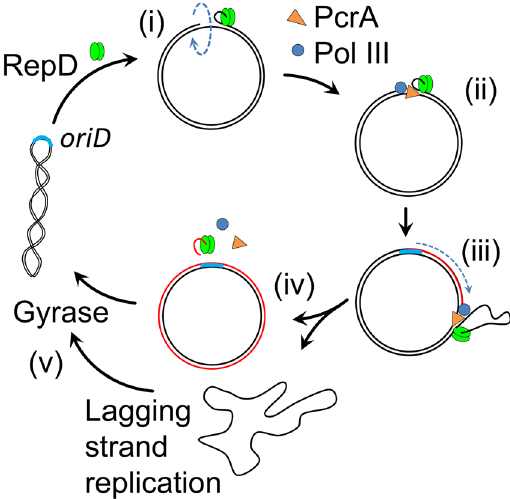
Figure 1. The rolling circle plasmid replication (i) The initiator protein (RepD, green) nicks DNA at the site of double-stranded origin oriD making a covalent complex with DNA. (ii & iii) PcrA helicase (orange) binds the exposed section of single-stranded DNA, unwinding the parent plasmid DNA allowing DNA polymerase III (blue) to commence synthesis of a new DNA strand (red strand). (iv) After DNA synthesis has proceeded all the way around the plasmid, reaching the region of oriD , replication is terminated, RepD is released along with the single-stranded DNA which is then replicated by another round of DNA synthesis. (v) Finally, the two newly synthesized daughter plasmids are supercoiled by DNA gyrase so that further rounds of replication may